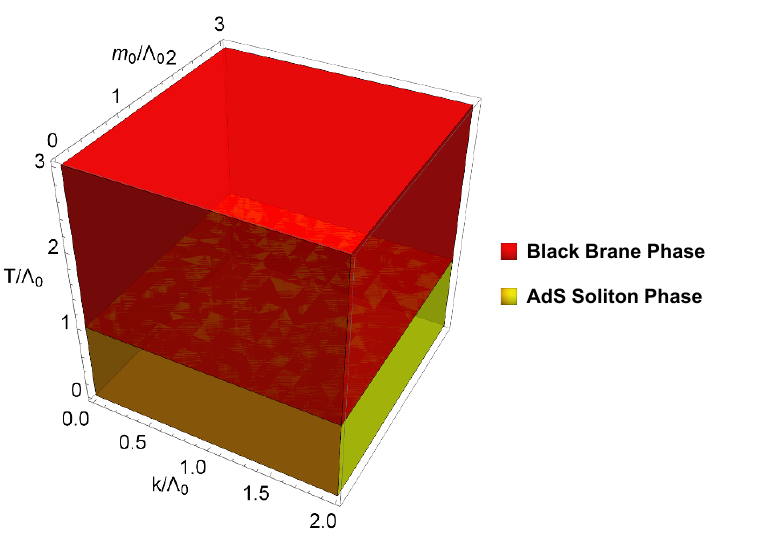
Figure 4. The phase diagram of the gravity model. The AdS Q-solitons(Con(cid:12)ning Phase) have smaller free energies than the Q- lattice black branes(Decon(cid:12)nement Phase) at the same m 0 = (cid:3) 0 and k= (cid:3) 0 below T = (cid:3) 0